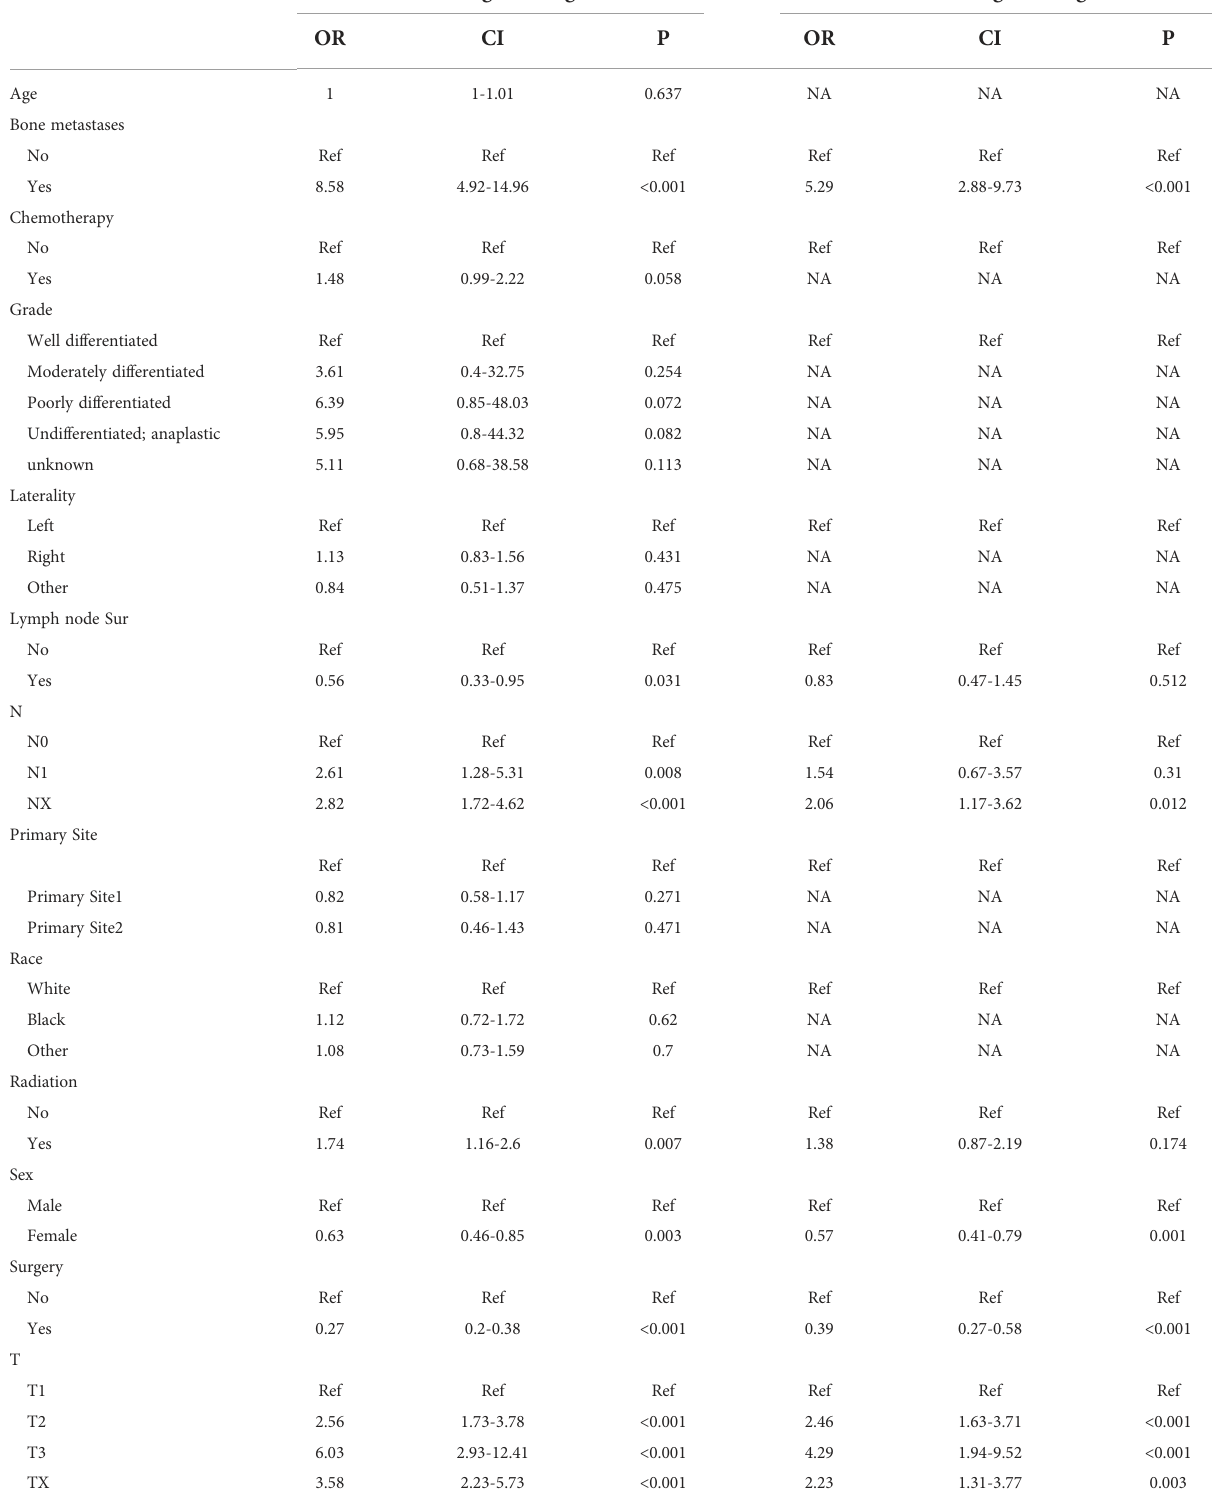
TABLE 1 Univariate and multivariate Logistics regression for pulmonary metastasis of osteosarcoma.